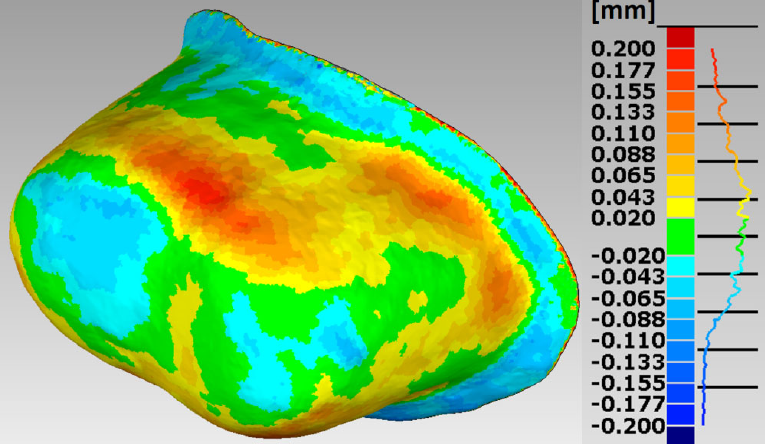
Figure 8. Map of errors in mapping the shape of a crown made of Ti6Al4V alloy in the milling for premolar 15.